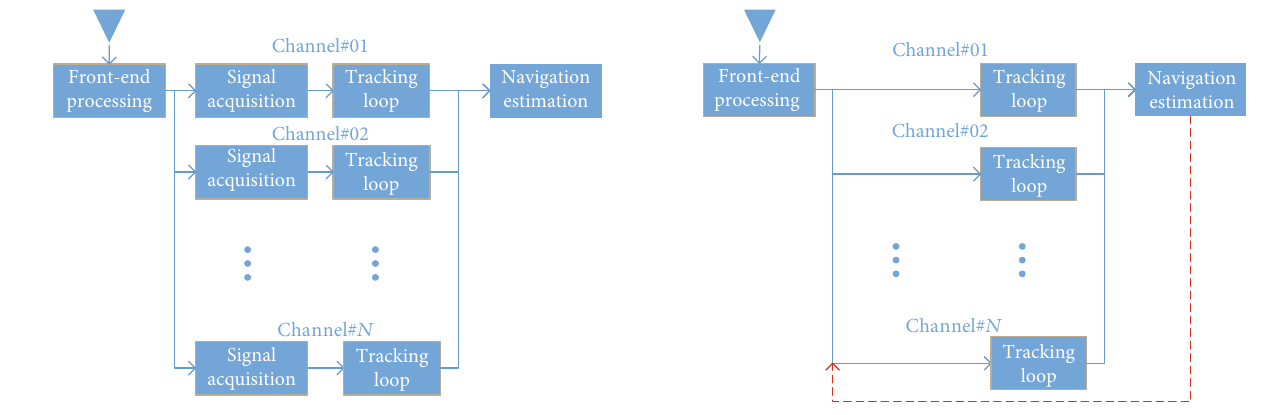
Figure 1: Scheme of the Scalar Tracking Loops. Figure